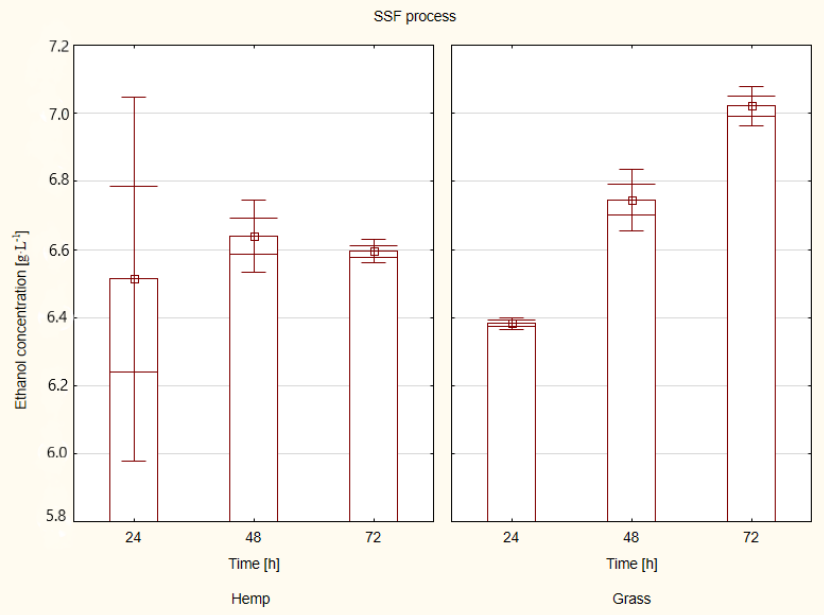
Figure 3. Ethanol concentration of hemp and grass biomass after the SSF process (Statistica 13.0).